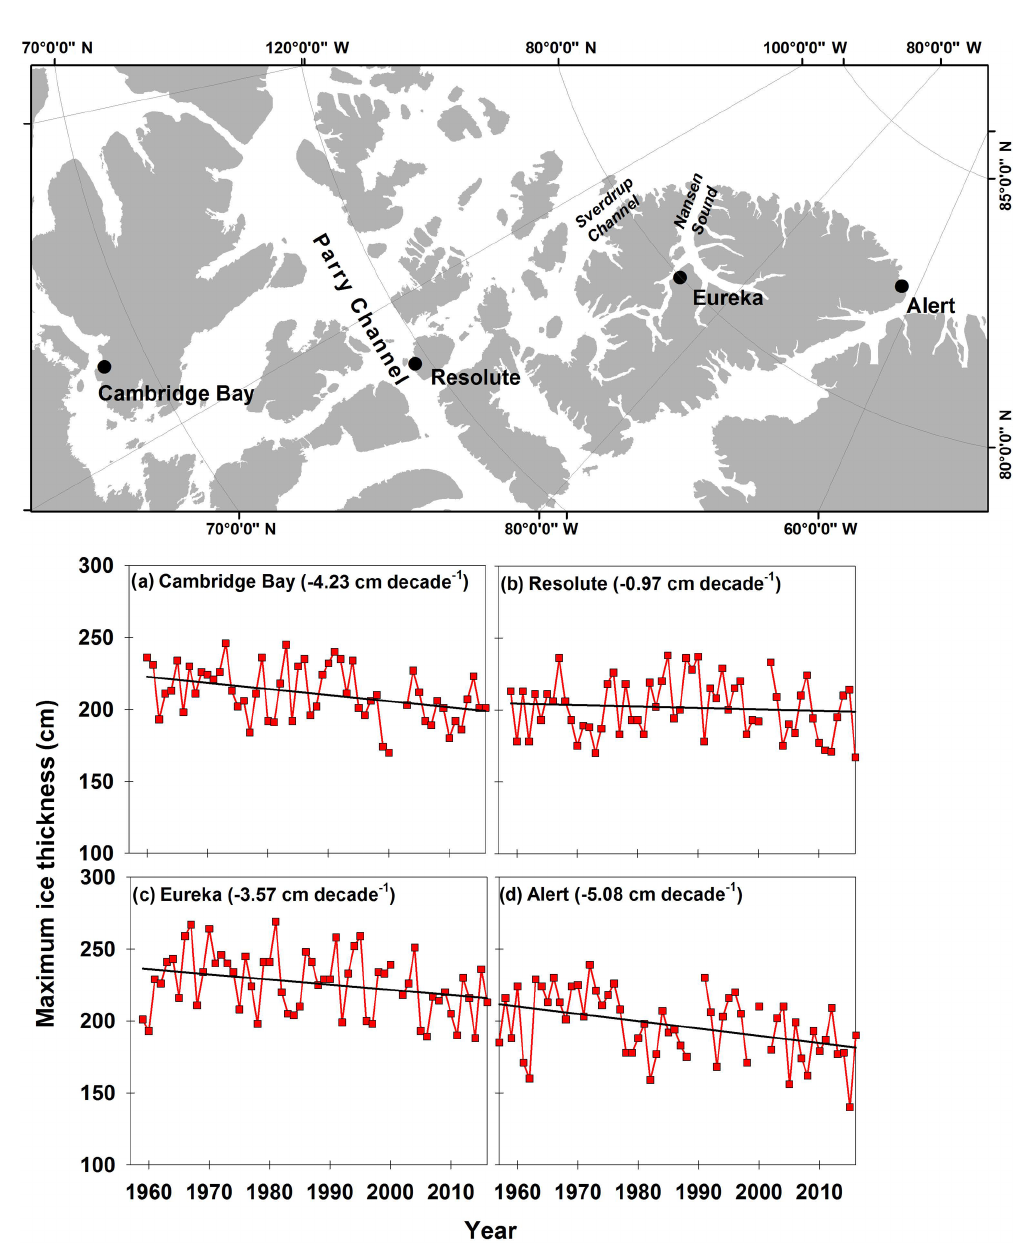
Figure 8. Time series and trend of observed maximum ice thickness at (a) Cambridge Bay, (b) Resolute, (c) Eureka, and (d) Alert locations in the Canadian